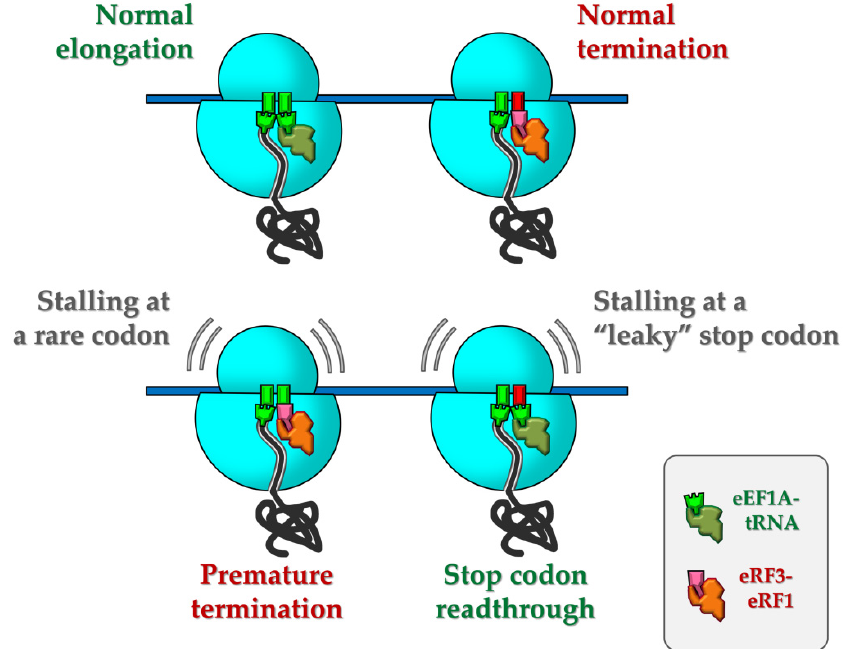
Figure 5. Model of stalling-induced nonsense suppression and premature termination. (Top) Regular elongation and termination that normally occurs at sense (green rectangles) and stop codons (in red), respectively. (Bottom) a rare codon (left) or a read-through-promoting context of stop codon (right) cause temporary stalling, which might be resolved in inappropriate ways due to ribosome binding of release factors to sense codon or a suppressor tRNA to the stop codon, leading to premature termination or read-through, respectively. eEF1A is shown by the dark-green figure, the eRF1–eRF3 complex by the rose and orange ones.